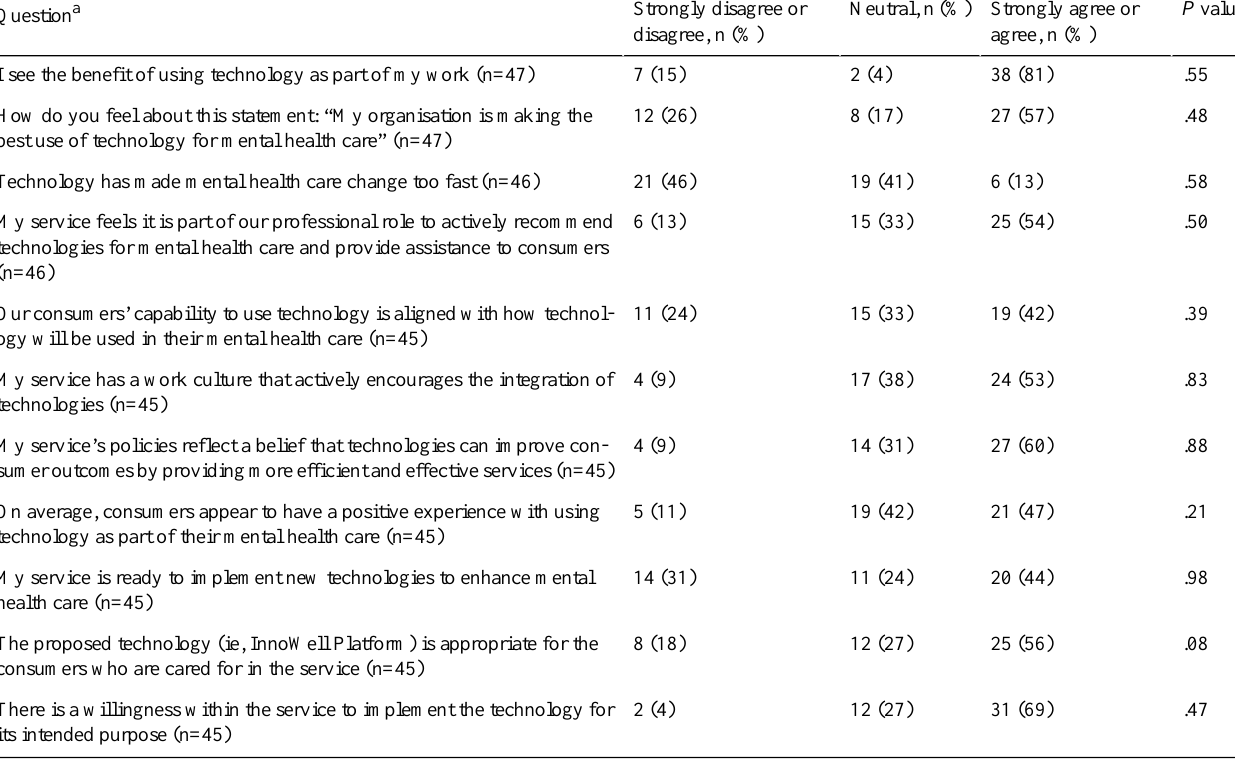
Table 2. Differences in aggregated web-based survey responses from participants based on the participating